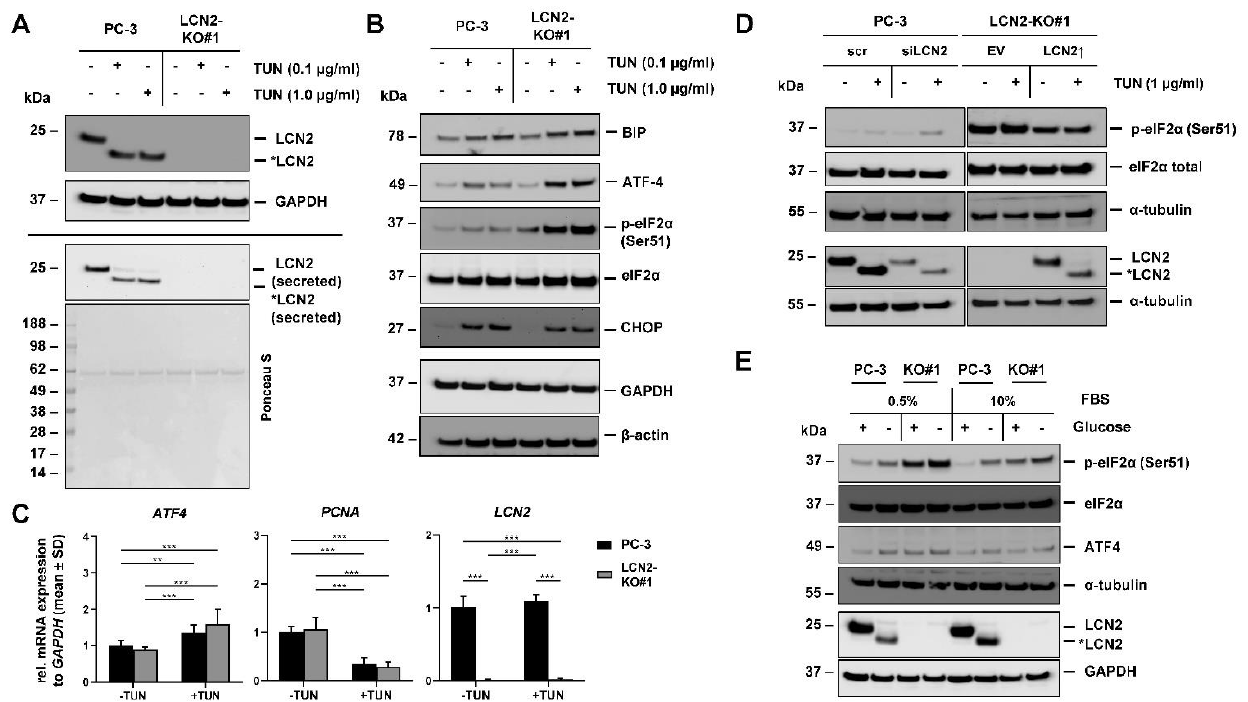
Figure 6. LCN2 deficiency affects response to ER stress in vitro. Parental PC-3 and LCN2-KO#1 cells were treated with indicated concentrations of tunicamycin (TUN) for 24 h. Supernatants were collected, and lysates harvested for protein or mRNA analysis. ( A ) TUN treatment prevents glycosylation of LCN2 in PC-3 cells as evidenced by detection of non-glycosylated form of LCN2 (*LCN2) in both cell lysates and supernatants. Secreted LCN2 levels are shown with corresponding Ponceau S stain. ( B ) TUN treatment enhanced different unfolded protein response (UPR) markers on protein level (n ≥ 3) in LCN2-KO#1 and PC-3 cells. ( C ) Quantitative mRNA analysis of ATF4 , PCNA and LCN2 was performed in PC-3 and LCN2-KO#1 cells treated with TUN (1 µg/mL) for 24 h (n = 3). Significant changes were detected between LCN2-KO cells compared to parenteral PC-3 cells. mRNA expression was normalized to GAPDH and given in relation to expression in parenteral PC-3 cells. Differences between the groups reaching significance are indicated as a ** p < 0.01, and *** p < 0.001, respectively. ( D ) PC-3 cells were treated with siLCN2 (35 nM) or scr siRNA for 24 h, while expression in LCN2-KO#1 cells were restored by transfection of a plasmid directing hLCN2 expression. Cells transfected with empty vector (EV) served as control. After 24 h, both cell lines were treated with TUN (1 µg/mL) for further 24 h and Western blot analysis were performed to detect p-eIF2α and LCN2 (n ≥ 2). ( E ) PC-3 and LCN2-KO#1 cells were cultured in medium with or without glucose (containing 0.5% or 10% FBS) for 48 h. Western blot analysis showed induction of p-eIF2α and ATF-4 in both cell lines, as well as non-glycosylated form of LCN2 (*LCN2) in PC-3 cells under glucose deprivation conditions (n = 3). In Western blot analysis, α-tubulin, β-actin, or GAPDH expression served as internal protein loading controls.